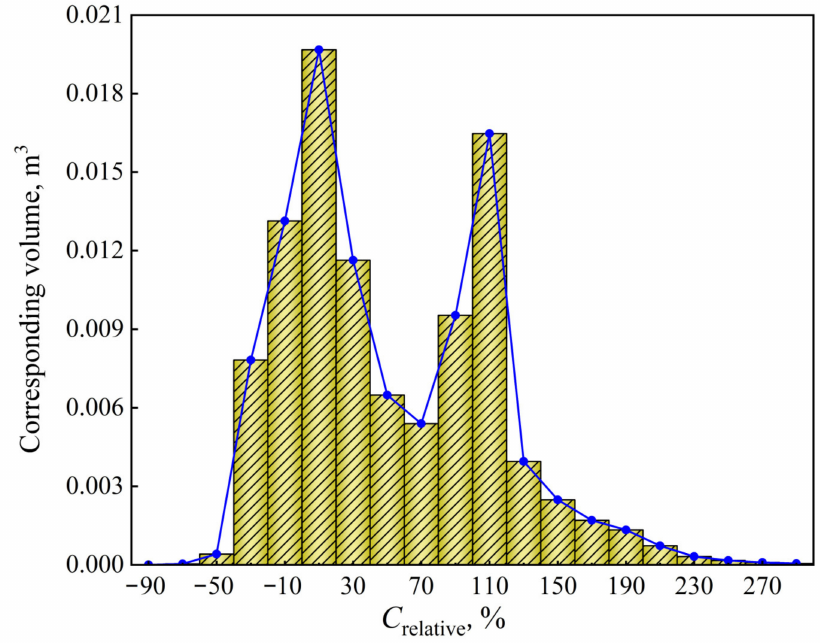
Figure 15. Corresponding volume of each range of relative segregation ratio after